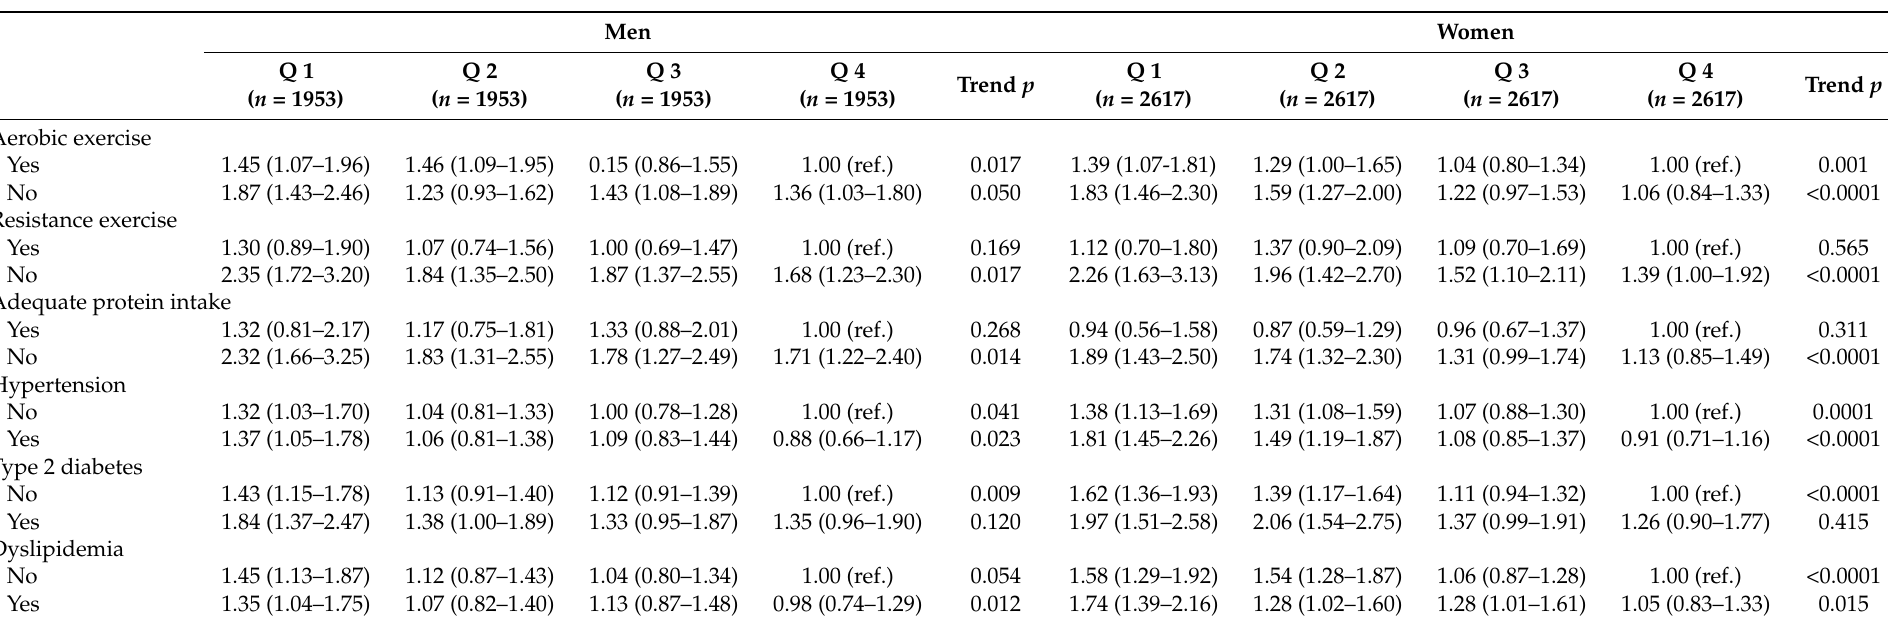
Table 4. Odds ratios (95% CI) of dietary omega-3 polyunsaturated fatty acids intake on low muscle strength considering resistance exercise, protein intake, and comorbidities. Men